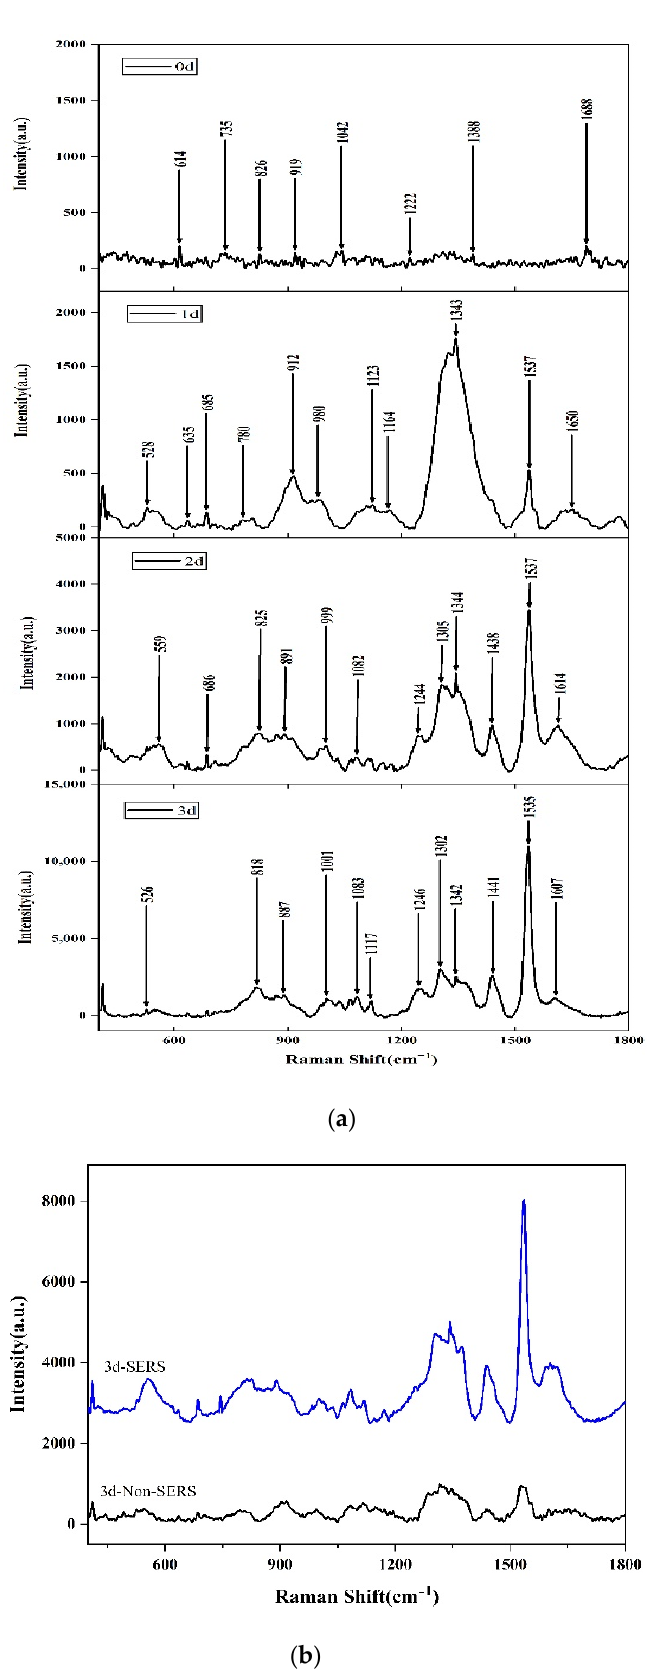
Figure 2. ( a ) SERS of Aspergillus flavus on the medium in different culture periods. ( b ) The comparison of non-SERS and SERS of Aspergillus flavus.